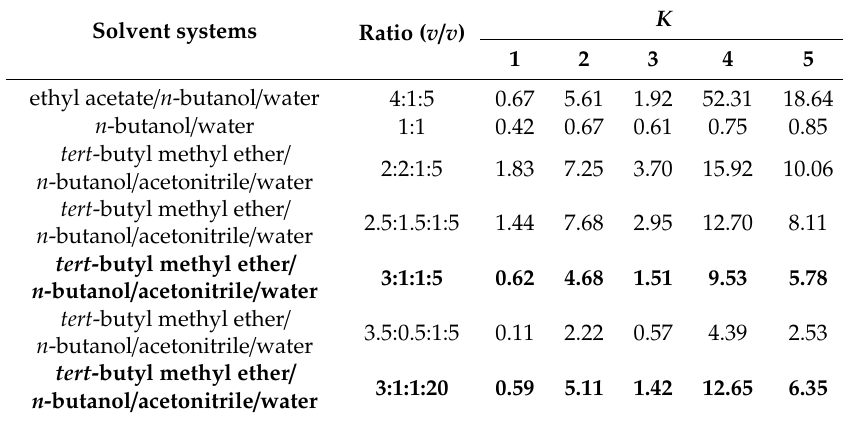
Table 1. The K values of target compounds in HSCCC separation with di ff erent solvent systems. Solvent